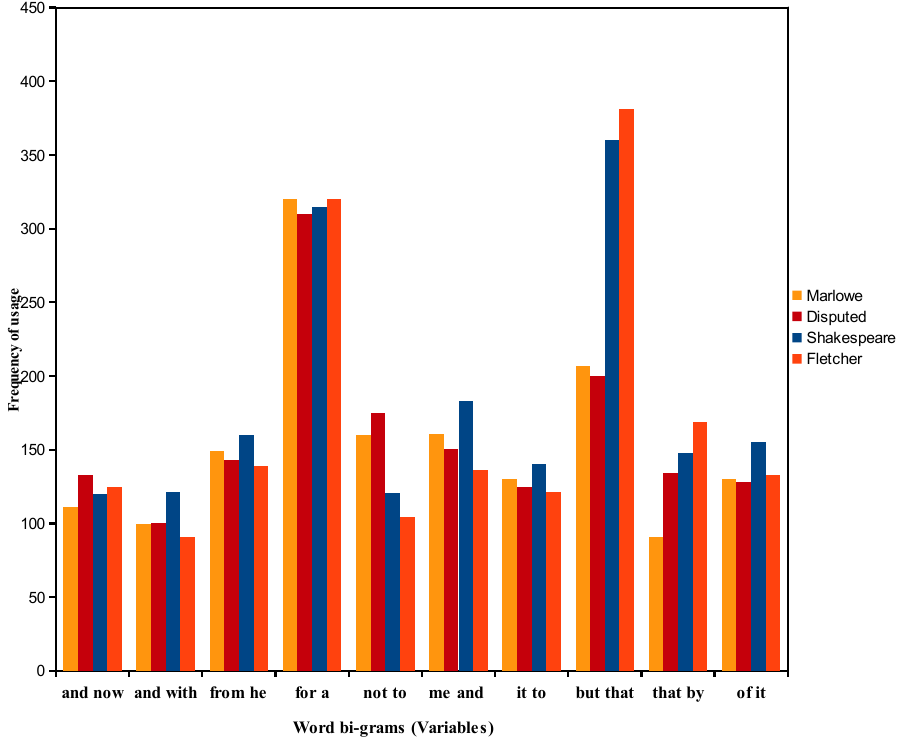
Figure 29. Words bi-gram centroid-based bar plot for Shakespeare, Marlowe, Fletcher, and the disputed